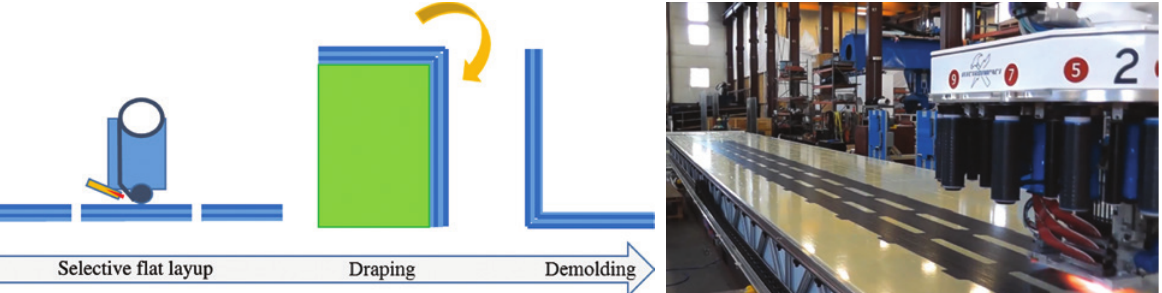
Figure 4: Schematic of selective flat AFP layup of multiple flat preform shapes (left) and manufacturing close-up (right). Source: www.electroimpact.com